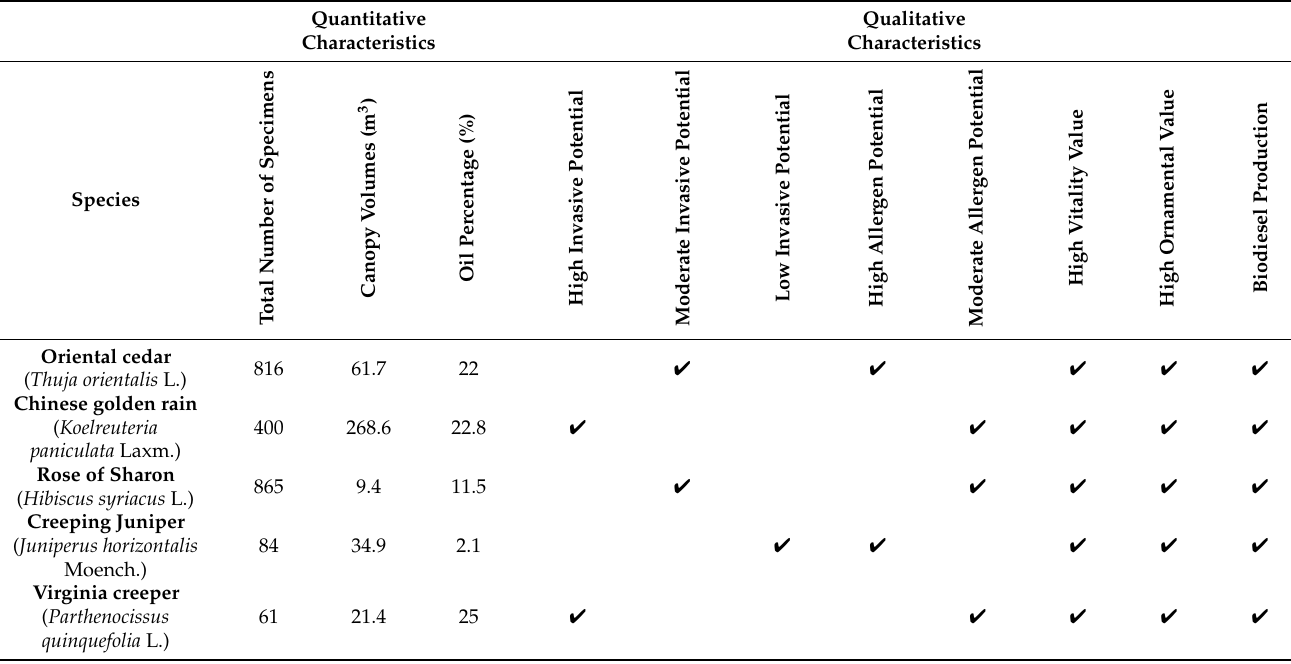
Table 4. Assessment of the quantitative and qualitative characteristics of ornamental species on public green areas in the inner city of Novi